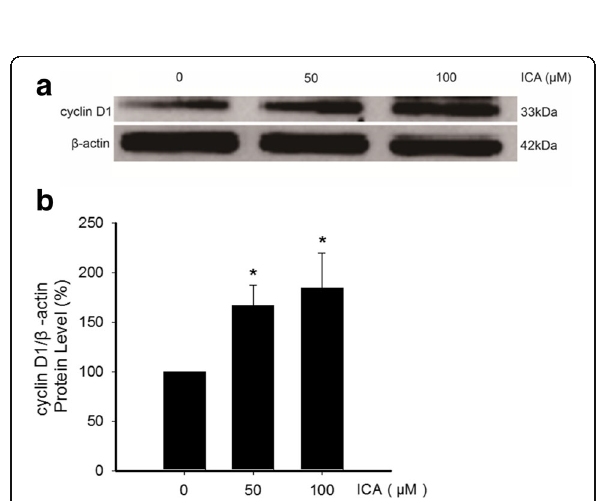
Fig. 6 Effect of ICA on cyclin D1 protein level in NSCs. The expression of cyclin D1 protein was determined by Western blot, and β -actin was used as loading control. a Representative blotting of cyclin D1 protein expression. b Quantitation of cyclin D1 protein level. Values represent mean±SD of five individual experiments. * P <0.01 vs